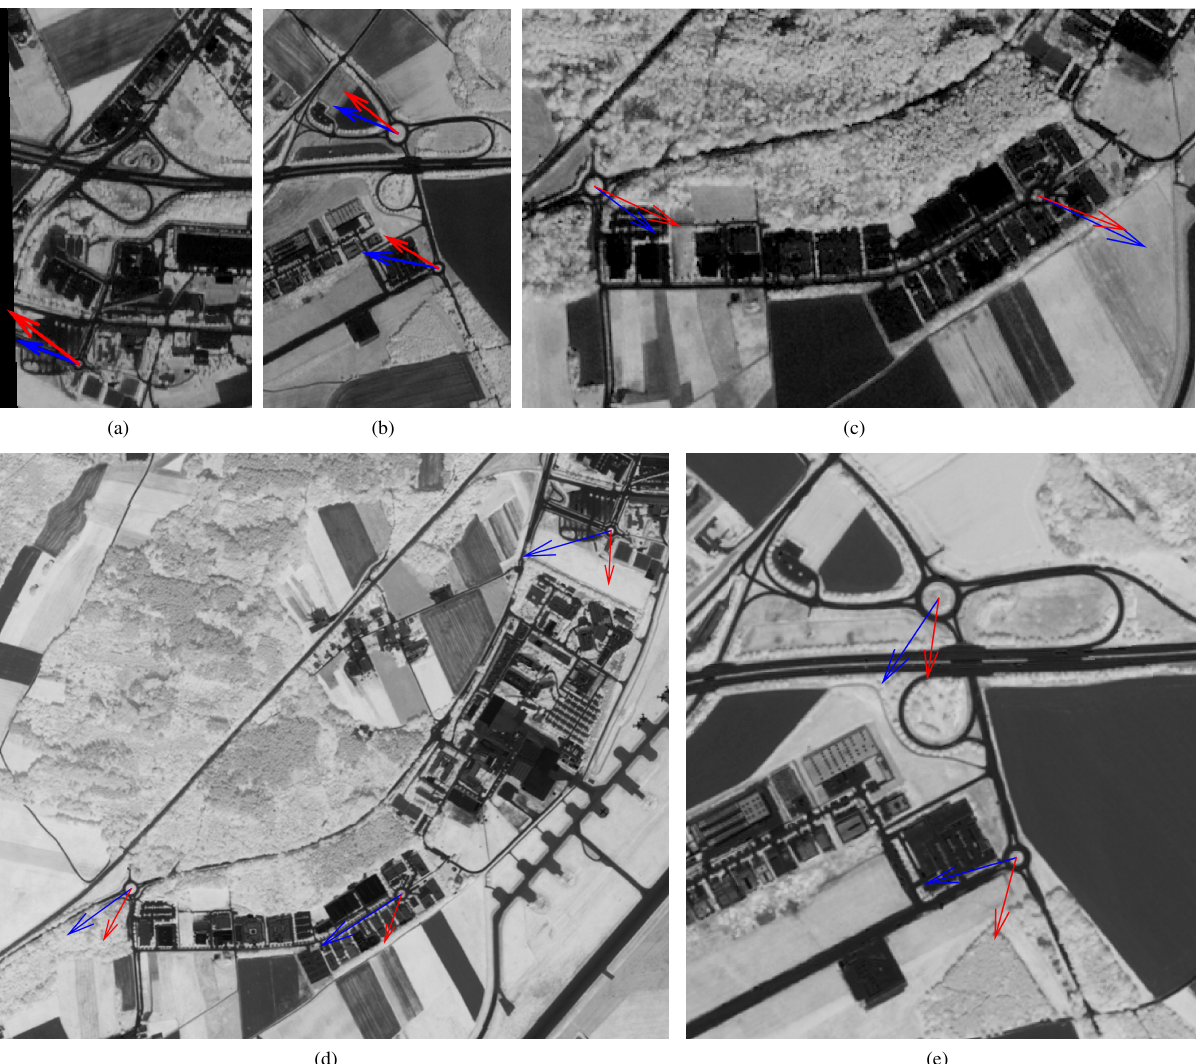
Figure 5: Illustration of the distance between the GCPs and the roundabout centers detected from the optical images (red vectors) and the distance between the detected roundabout center from the optical image to the roundabout center from the reference data (blue vectors). Figure (a), (b) and (c) show a subset of the QuickBird images (NDVI) and the vectors are scaled by a factor of 25 . Figure